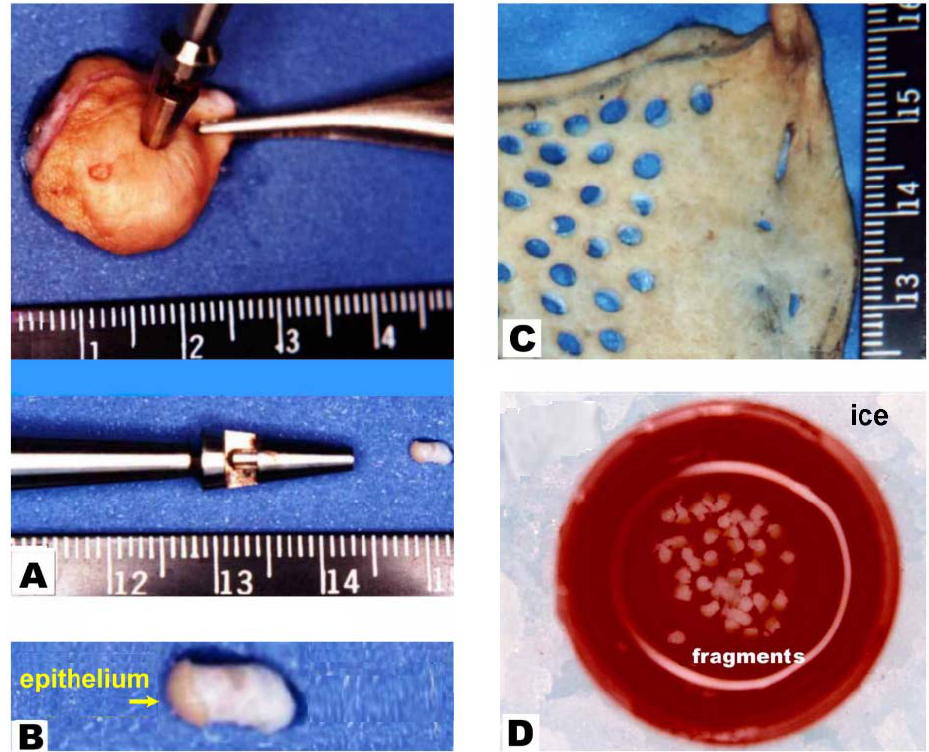
FIGURE 2 – Method for obtaining skin or keloid fragments